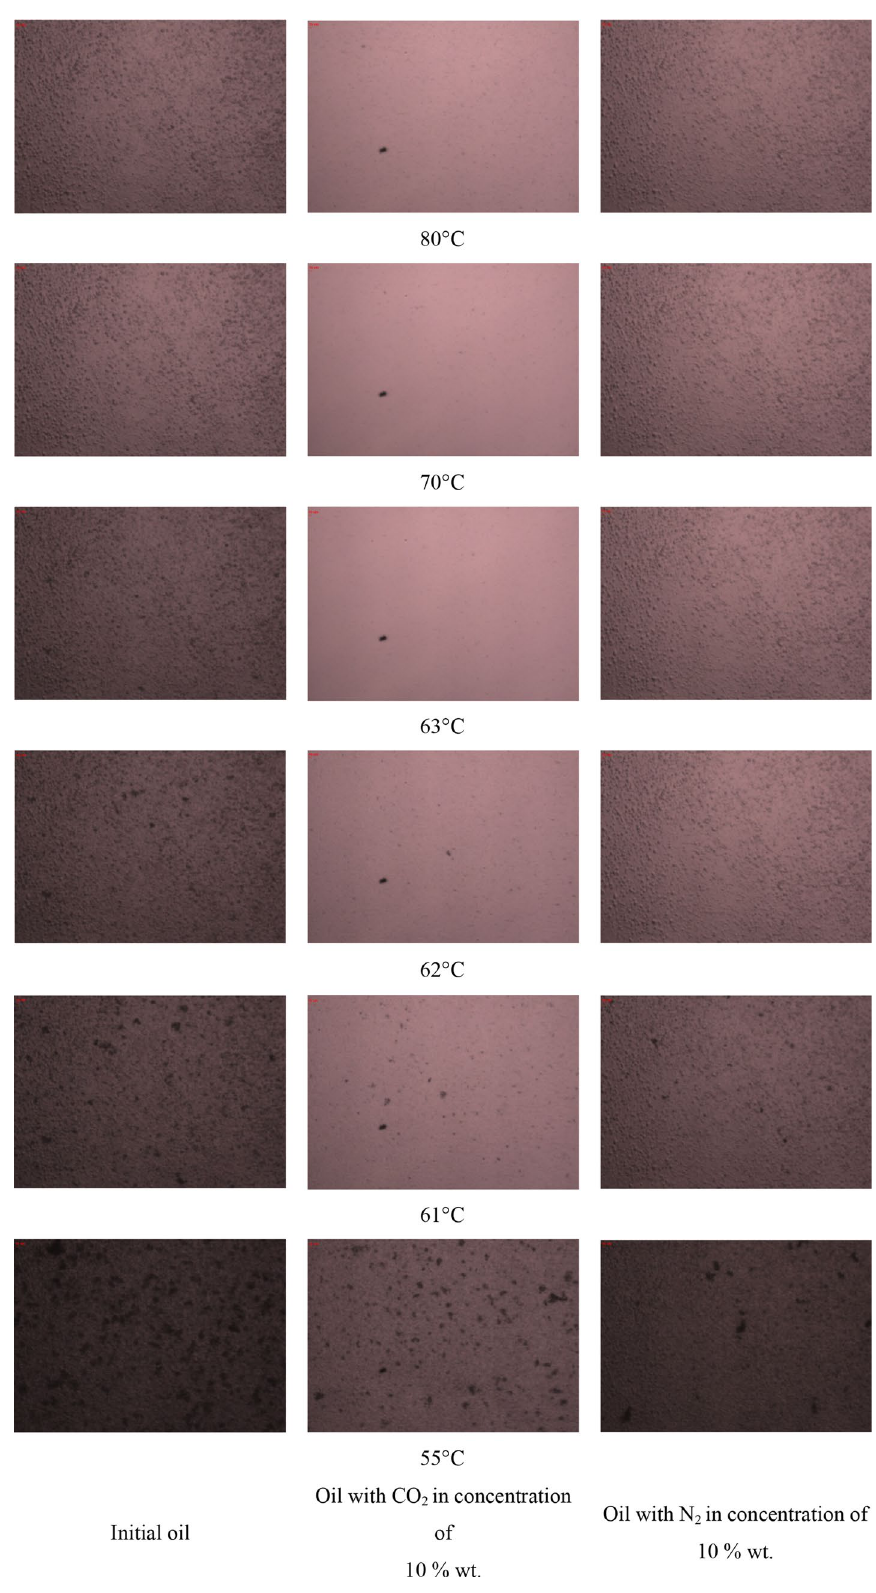
Fig. 11 Micrographs of oil samples at temperature decrease and reservoir